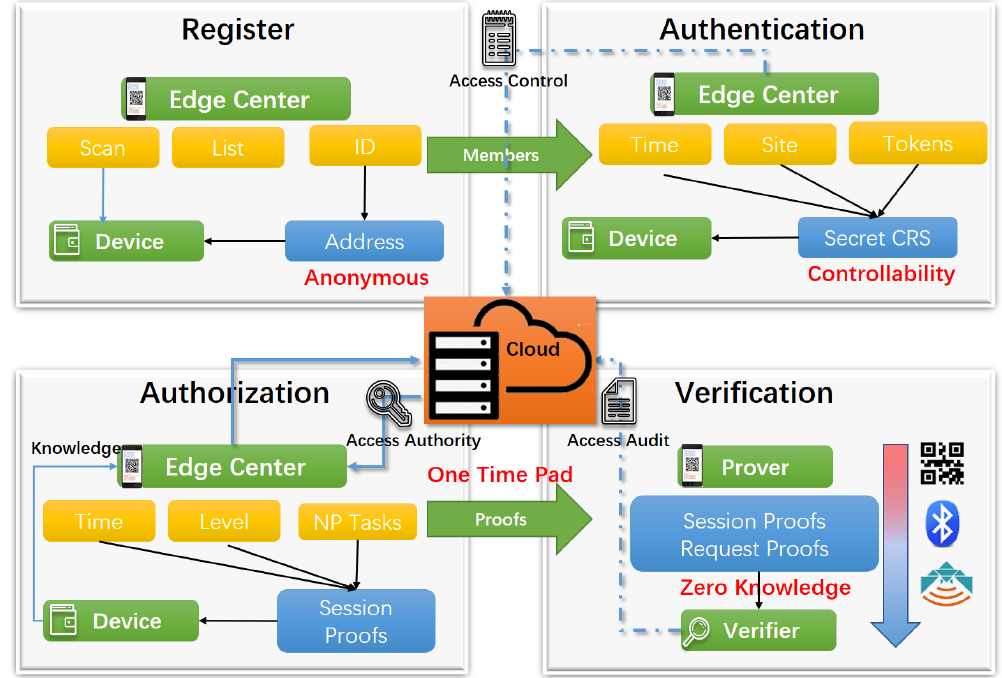
Figure 1. System diagram of one-time association multitask proofs for peer to local authentication